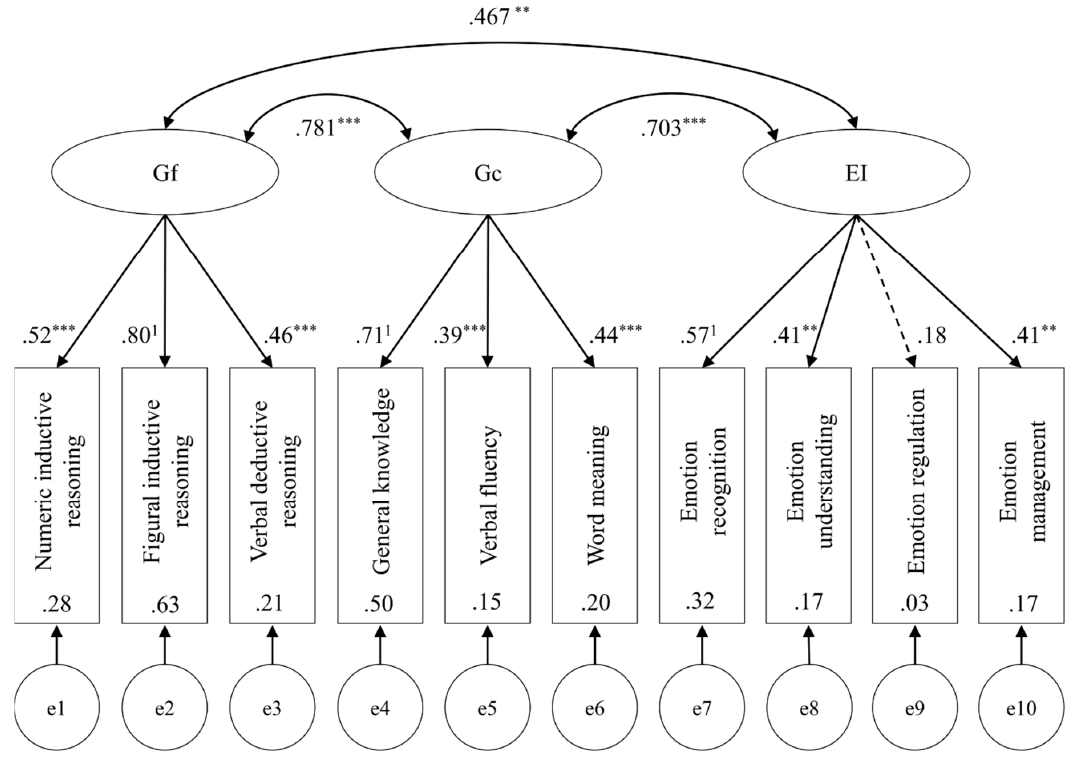
Figure 2. Theoretical group factor model (Model 2).